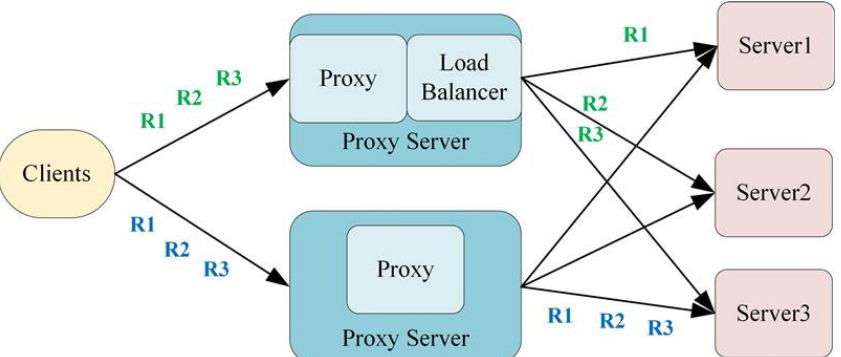
Figure 6. Proxy server connecting to the cloud with/without request-based load balancing.